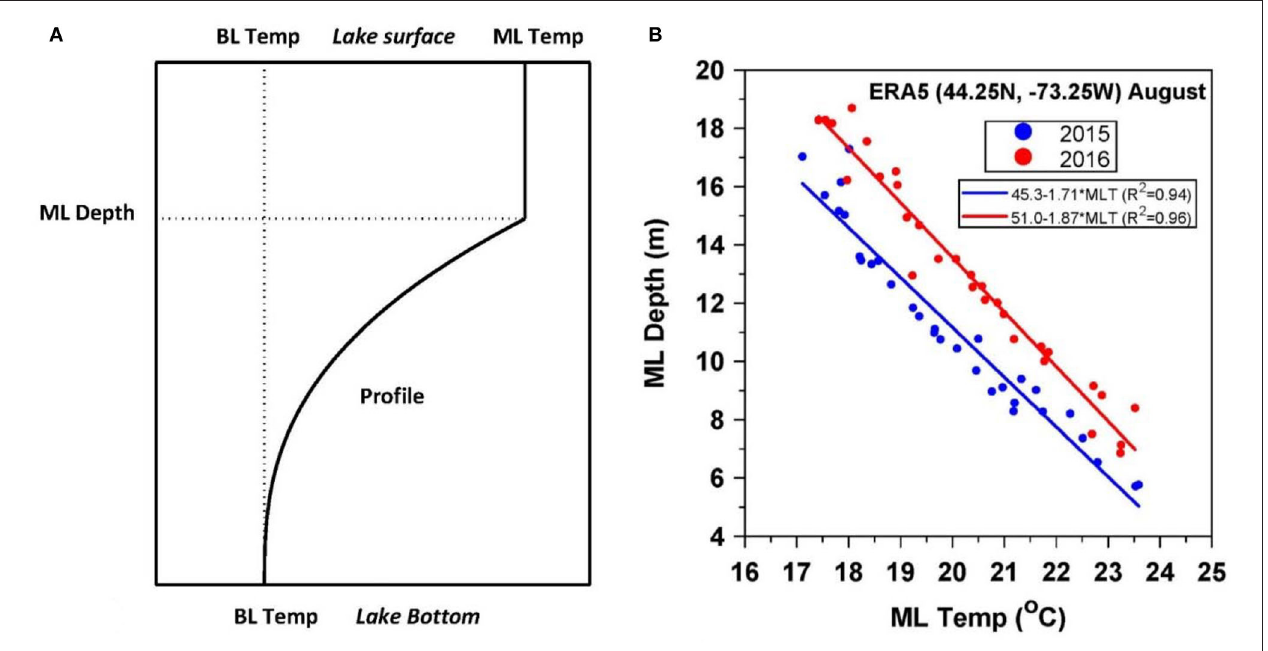
FIGURE 2 | (A) Idealized self-similar profile in the FLake model and (B) Tight coupling on daily timescales between ML temperature and ML depth in